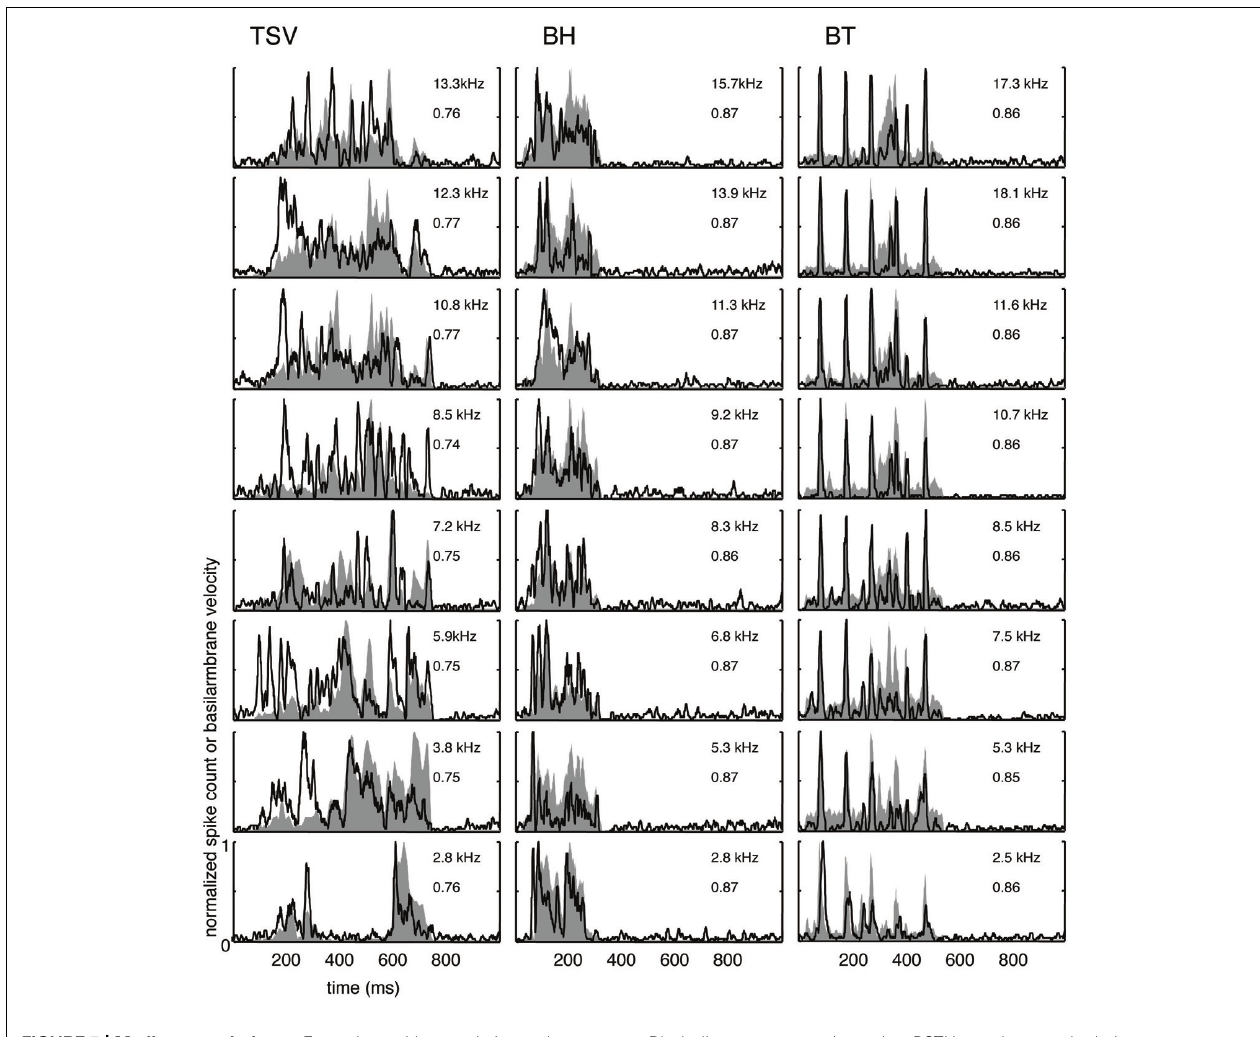
Black lines correspond to the PSTHs and gray shaded areas correspond to the DRNL outputs. The best frequency and the peak correlation value for each recording site are labeled on the top-right of each